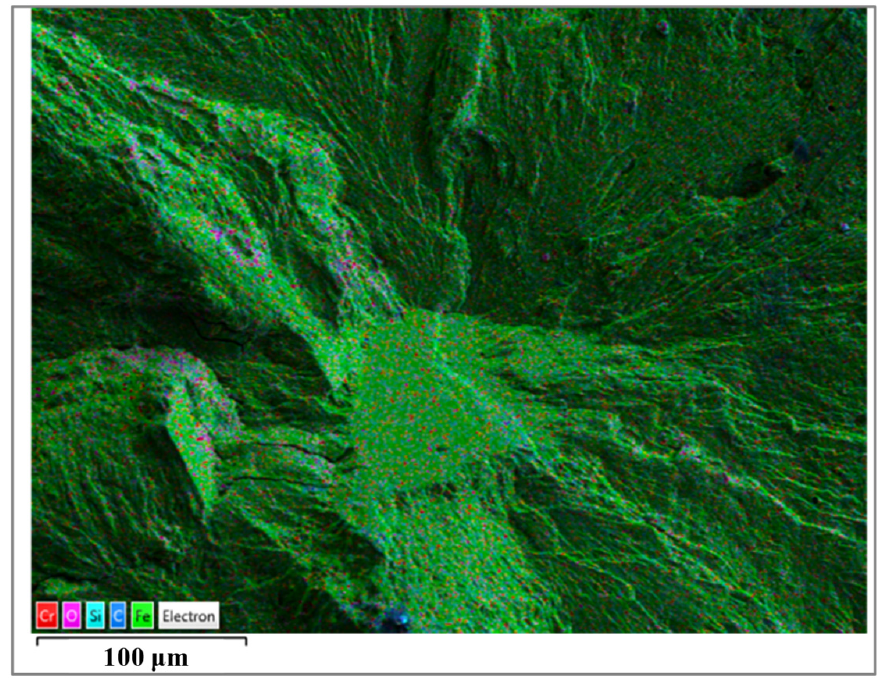
Figure 12. EDS analysis of the fish-eye nucleation zone.